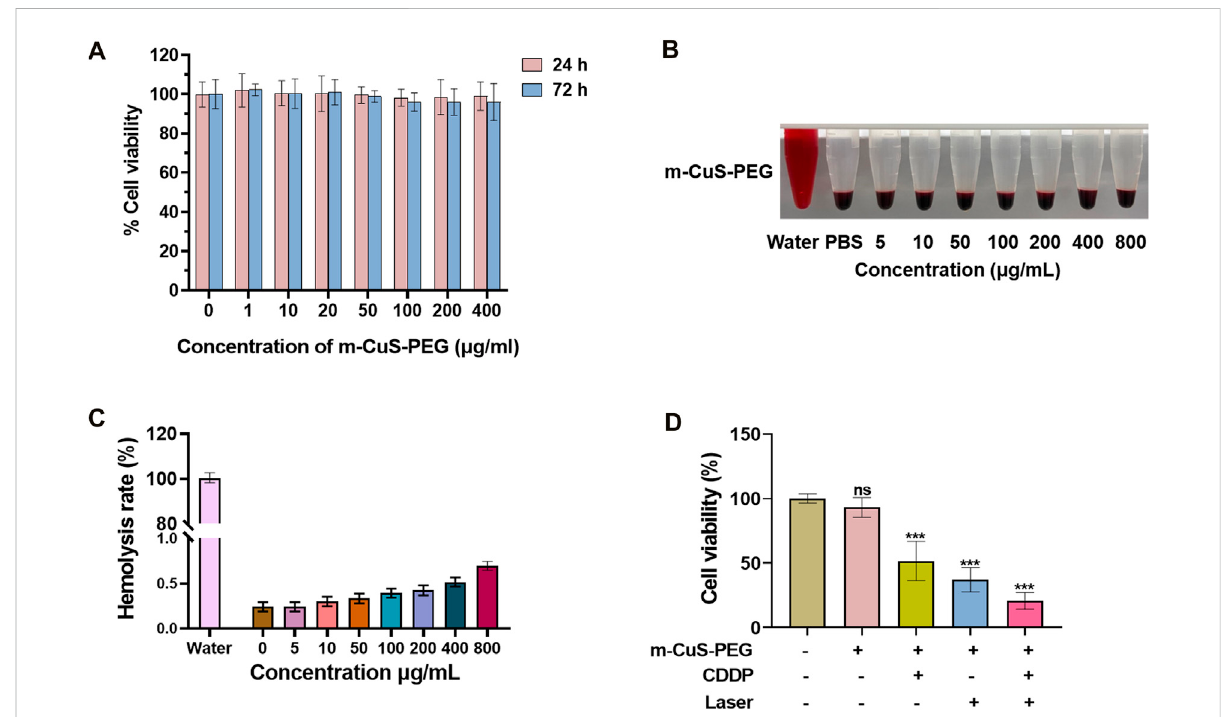
FIGURE 4 In vitro photothermal killing effect of CDDP@m-CuS-PEG on tumor cells. (A) Cell viability assay of MDA-MB-231 cells incubated with m-CuS- PEG at different concentrations (0, 1, 10, 20, 50, 100, 200 and 400 μ g/ml) under NIR laser irradiation for 10 min every 12 h. (B) Cell viability assay of MDA-MB-231 cells incubated with m-CuS-PEG, free CDDP, m-CuS-PEG + Laser and PDD@m-CuS-PEG + Laser (100 μ g/ml); (C,D) Hemolytic properties of m-CuS-PEG at different concentrations. All sample sizes are